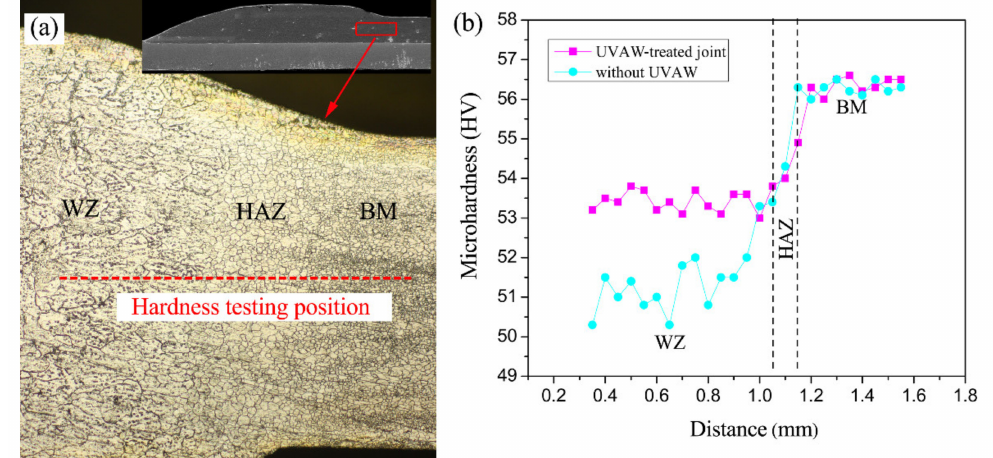
Figure 9. ( a ) The cross-sectional microhardness test point and ( b ) the microhardness curves of the galvanized steel/AZ31B joints obtained with and without UVAW.